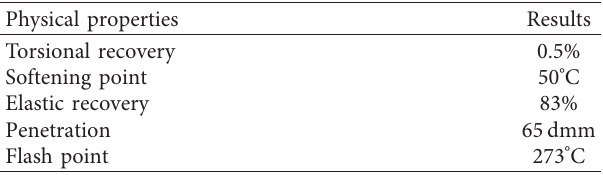
Table 1: The bitumen properties.